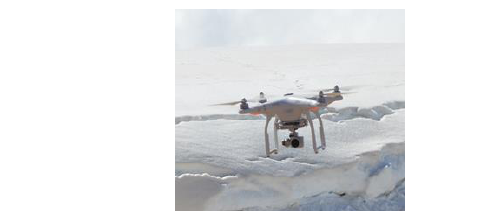
Figure 2: Phantom III Advance picture during flight mission at Jabal El Dib on March 28th 2017.